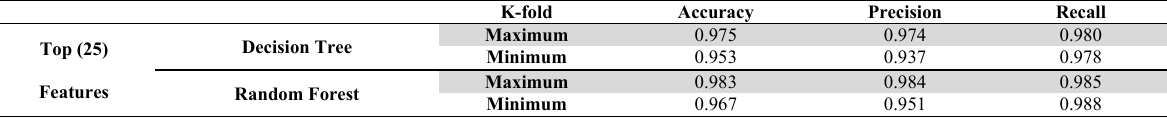
K-fold Accuracy Precision